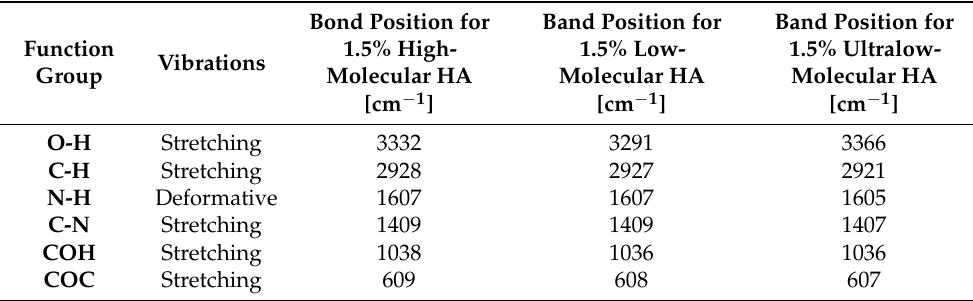
Figure 3. IR spectrum of the film obtained from the mixtures of high-, low-, and ultralow-molecular-weight HA with 1% solution of BSA. Table 1. The positions of bands in IR spectra (wavenumbers) for high-, low-, and ultralow-molecular-weight hyaluronic acid.